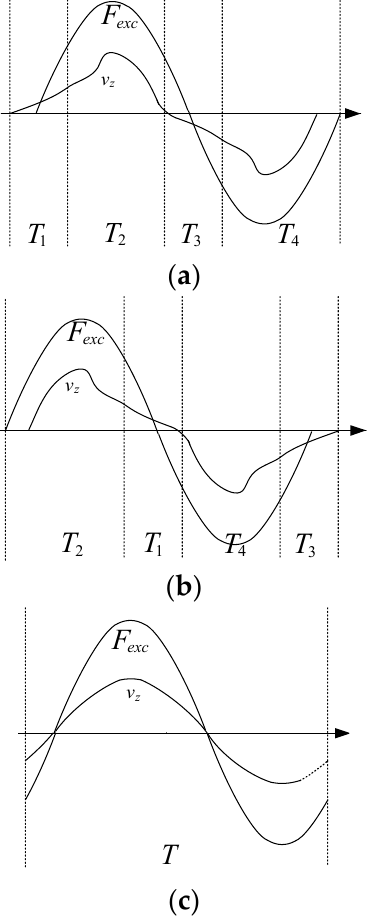
Figure 15. Phase analysis and domain partition of ocean wave power generation system. ( a ) Exciting